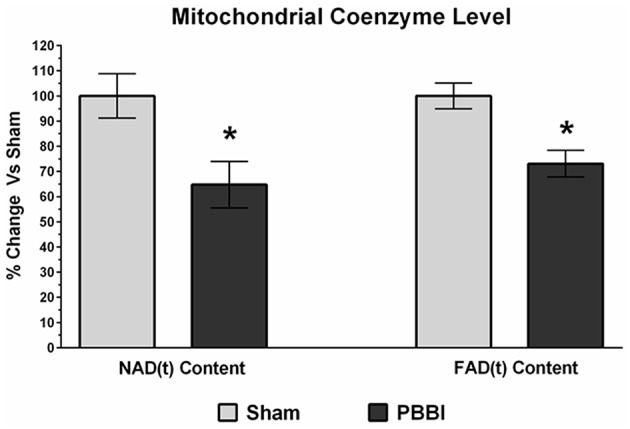
Decreased coenzyme contents following PBBI. At 24 h post-PBBI, significant reduction in mitochondrial coenzyme contents were detected. Both NAD(t) (35%, p < 0.05) and FAD(t) contents (27%, *p < 0.05) were decreased significantly in the PBBI group (Unpaired t-test, *p < 0.05). Bars represent group means ± SEM (n = 5 animals / group). *p < 0.05 compared to sham injured group (unpaired t-test).